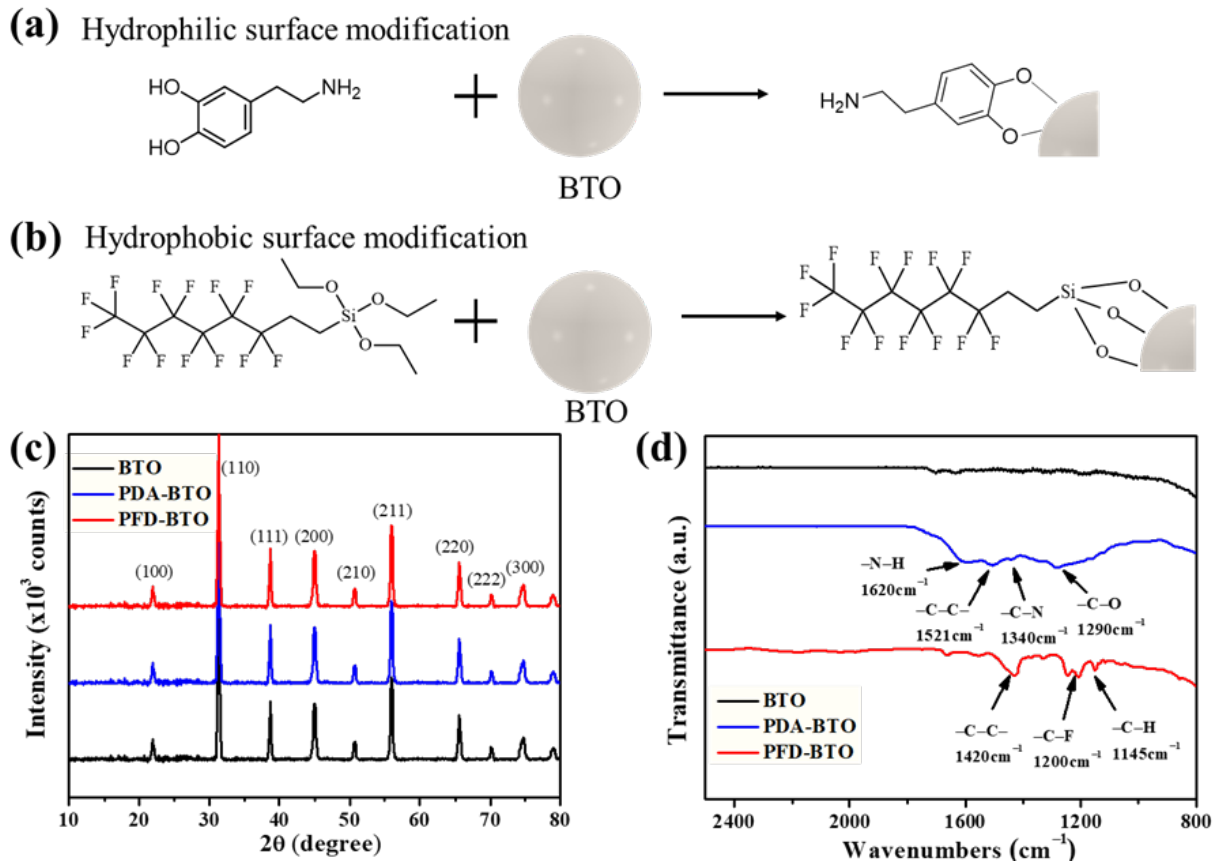
Figure 2. Schematic of the surface ( a ) hydrophilic and ( b ) hydrophobic modifications of BTO NPs. ( c ) XRD and ( d ) FTIR spectra of BTO NPs with surface hydrophilic and hydrophobic modifications.